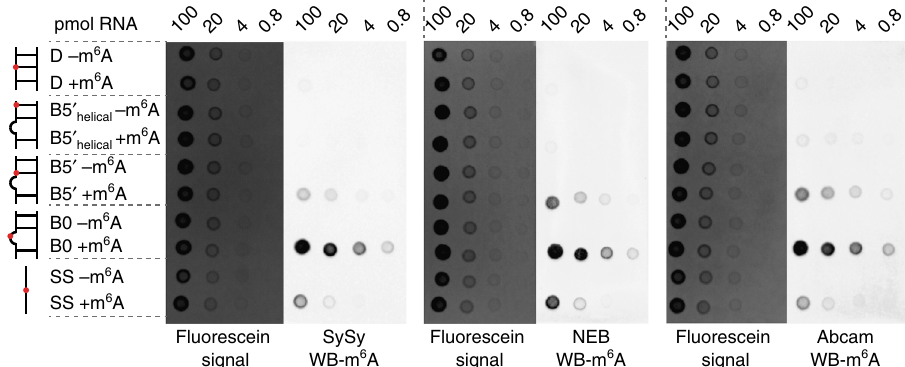
Fig. 5 m 6 A antibodies recognize m 6 A in B5 ʹ but not D. Dot blot assays assessing the antibody speci fi city for m 6 A in different secondary structure contexts. Increasing amounts of 5 ʹ fl uorescein labeled RNAs with and without m 6 A were spotted onto the membrane. The quantity of RNA was visualized by the fl uorescein signal. Three different m 6 A antibodies (SySy polyclonal, NEB monoclonal, Abcam polyclonal) were tested. Red dots in the schematic secondary structures represent the m 6 A sites. The SS construct used in dot blot assays is 5 ʹ -GGCGGm 6 ACUC-3 ʹ . Blots shown are representative of results from